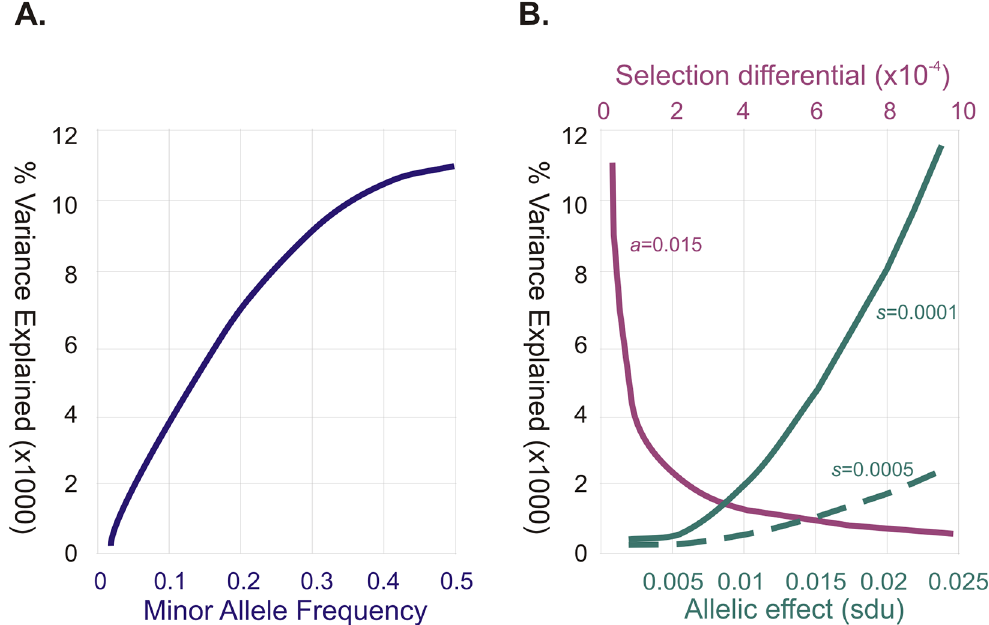
Fig 1. Relationships between allele frequency, selection differential, effect size, and variance explained. (A) The blue curve shows how the percent of variance explained varies as a function of minor allele frequency, p , namely %Variance Explained = 2 p (1- p ) a 2 . The curve assumes 1,000 alleles, each with an additive contribution, a , of 0.015 sdu’s (about 1 mm of human height). (B) Simons et al [2] demonstrate that for relatively strongly selected alleles, the variance explained per site, v s , is a function of the contribution to fitness in a population size N with degree of pleiotropy n . Specifically, v s = 2 w 2 / nN , and because the selection coefficient s = a 2 /w 2 , then v s = 2 a 2 /s nN . The magenta curve approximates the expected selection coefficient consistent with a = 0.015 in a population with an effective size of 10,000 alleles affecting 10 traits, and v s expected for 1,000 alleles to produce the indicated %Variance Explained: as selection increases, less variance is explained because the allele frequencies drop. Alternatively, the solid green curve assumes a constant s = 10 −4 and shows the effect sizes consistent with variation explained, while the dashed green curve shows how increasing the selection pressure 5-fold reduces the amount of variance that can be maintained. Alleles explaining on average 0.01% of the variance under these scenarios could be consistent with substitution effects of 0.015 sdu, intermediate selection coefficients approximately 5 × 10 −5 leading to minor allele frequencies about 0.33; or with a = 0.023, and s = 10 −4 and p ~ 0.1; with a = 0.05, and s = 5 × 10 −4 , p ~ 0.02, and so forth. sdu, standard deviation